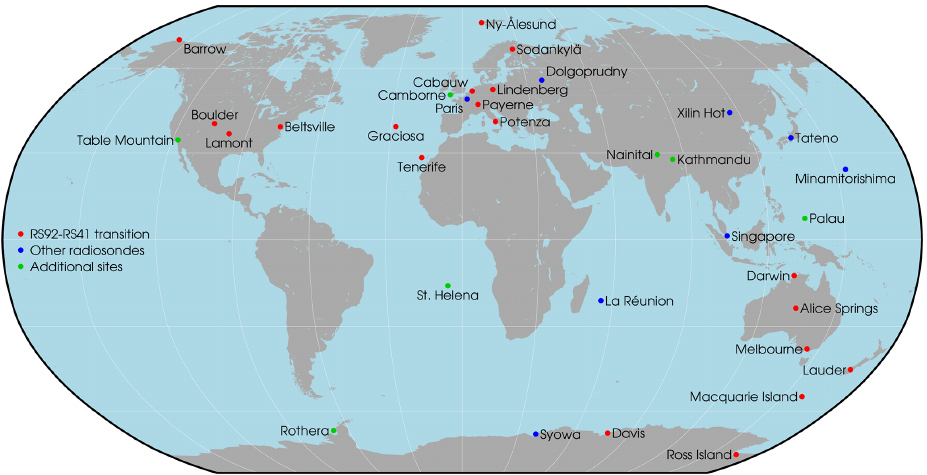
Figure 1. Locations of GRUAN sites and other transition-related sites (September 2019). Red dots represent sites that switched from RS92 to RS41 as their operational radiosonde. Blue dots represent sites that employ another type of radiosonde or that transitioned from another type to the RS41. Green dots represent sites which performed additional comparison launches and provided these data to GRUAN.